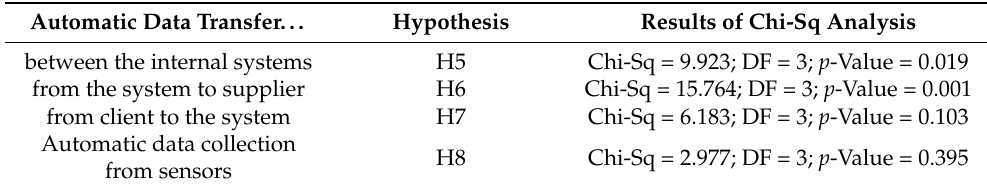
Table 3. Results of Chi-Sq analysis for automatic data transfer depending on company size.